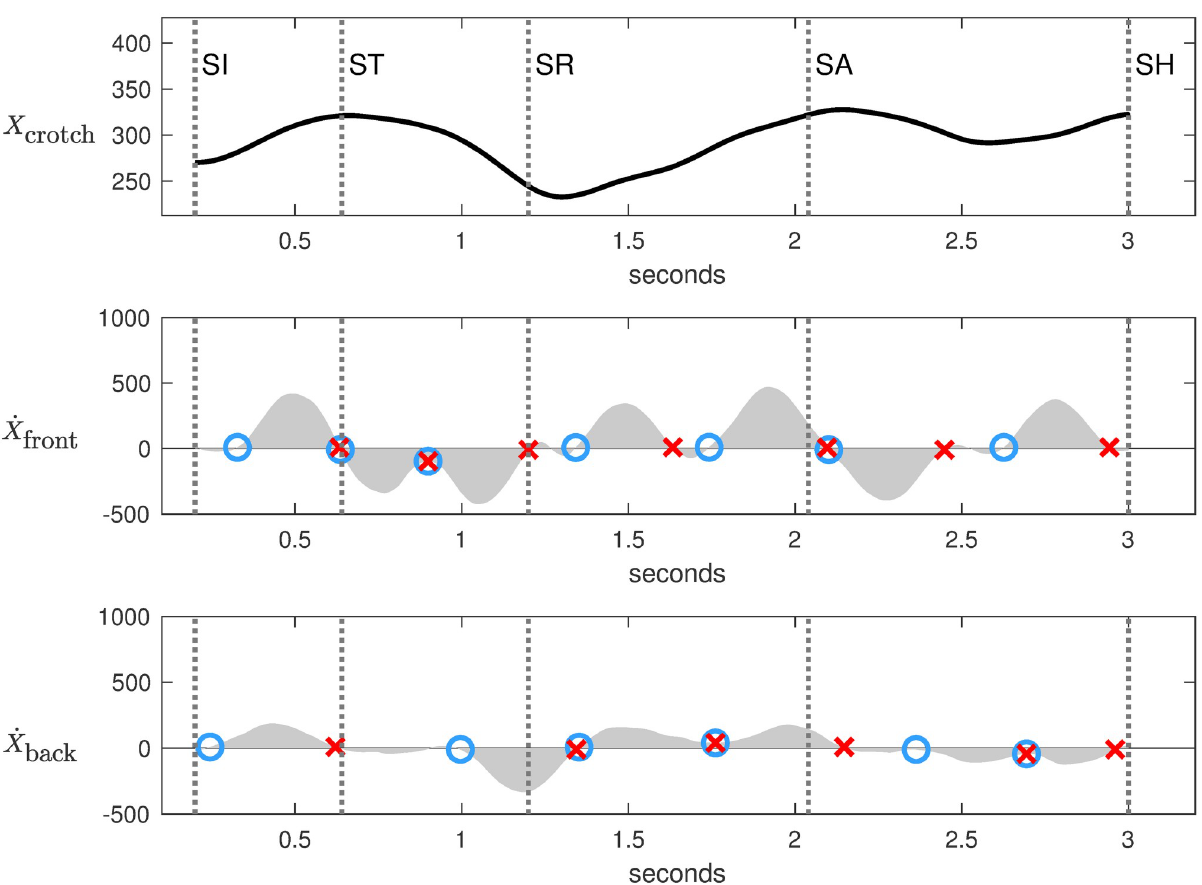
Fig 9. Footwork analysis of Grumier. X crotch is horizontal position of the crotch. _ X is horizontal velocity of the front foot. _ X is horizontal front back velocity of the back foot. Each step corresponds to a velocity bump (gray area) delimited between a blue circle and a red cross. velocity bump (gray area) delimited by an initial zero velocity (blue circle) and a final zero velocity (red cross). A positive bump corresponds to a step forward for Steffen and a step back- ward for Grumier, and vice versa for a negative bump. A manually adjustable threshold was used to ignore bumps of small amplitude. A red cross inside a blue circle characterizes two consecutive synchronized steps. This method resulted in the following analysis of footwork: